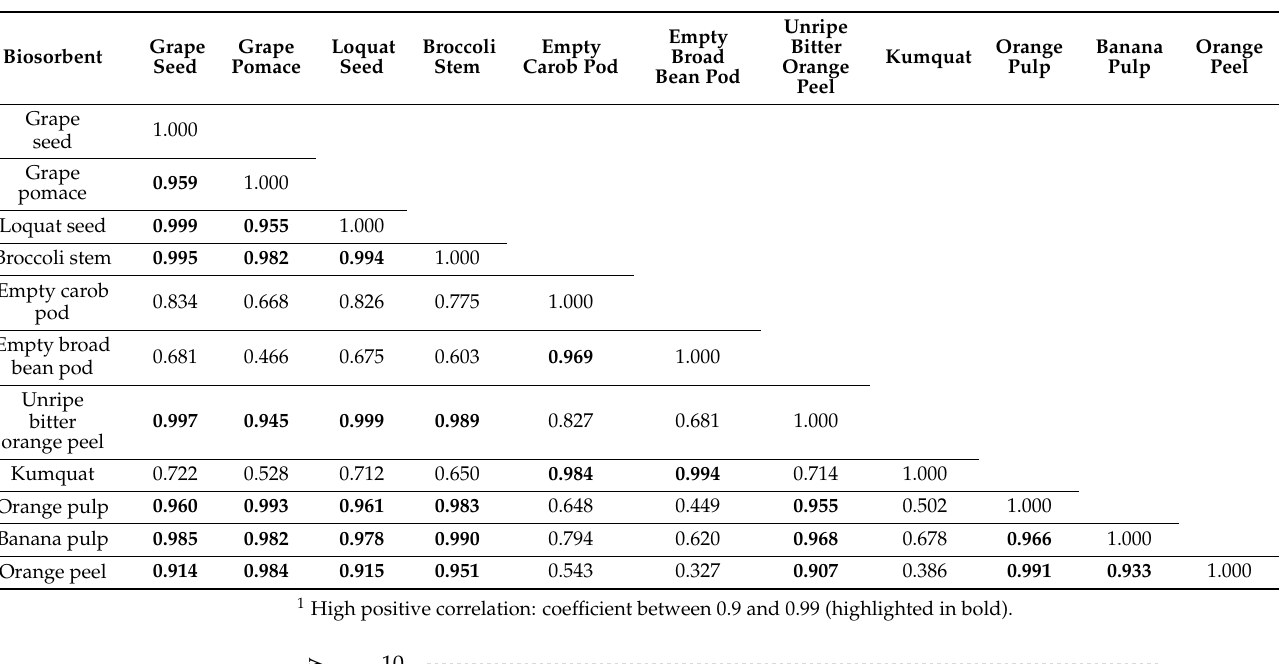
Table 6. Pearson correlation coefficients matrix 1 for normalized sorption capacity (Q t ’) of Cd(II), Co(II), Ni(II) and Pb(II) among the studied biomasses.